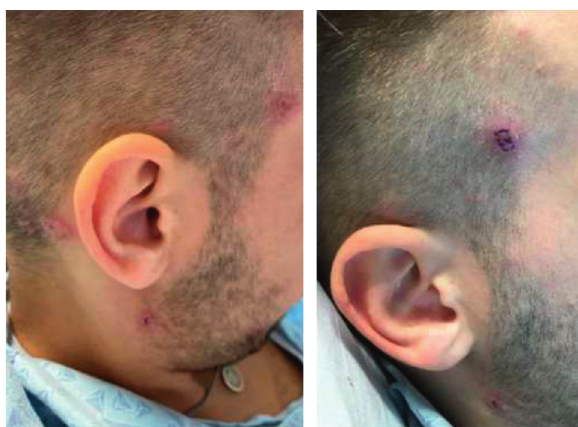
Figure 1: Firm, erythematous, and umbilicated papules with central erosion and crust. The lesions were observed on the face, scalp, and jaw.